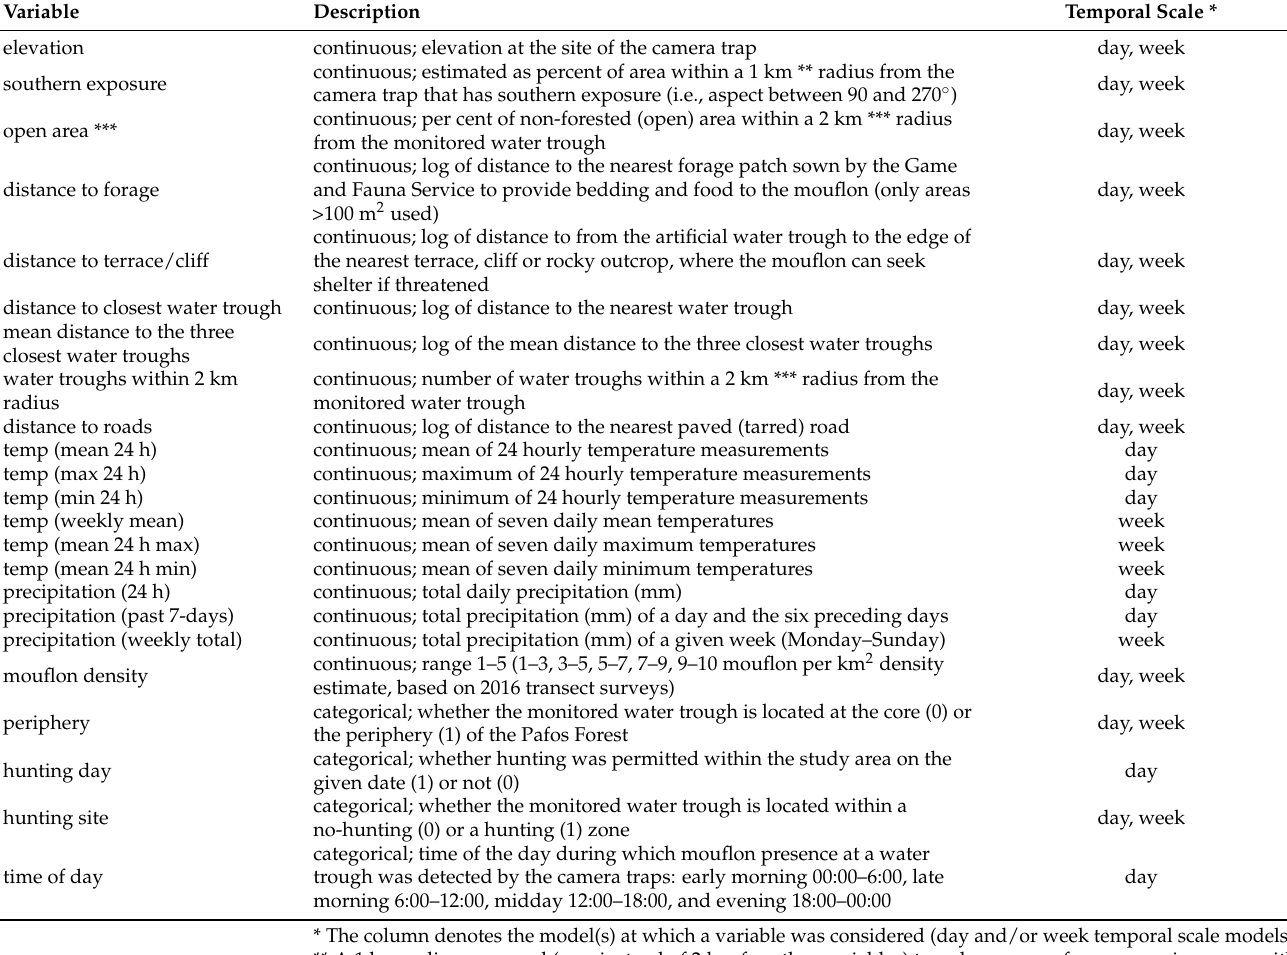
Table A1. Description of environmental, climatic, and anthropogenic variables considered in daily and weekly temporal scale models of mouflon visitation frequency at the ten monitored artificial water